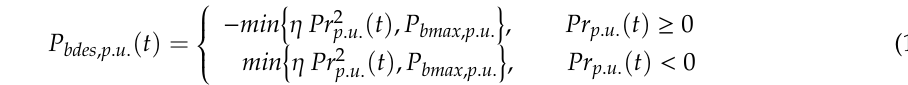
Figure 13. Battery model block diagram.